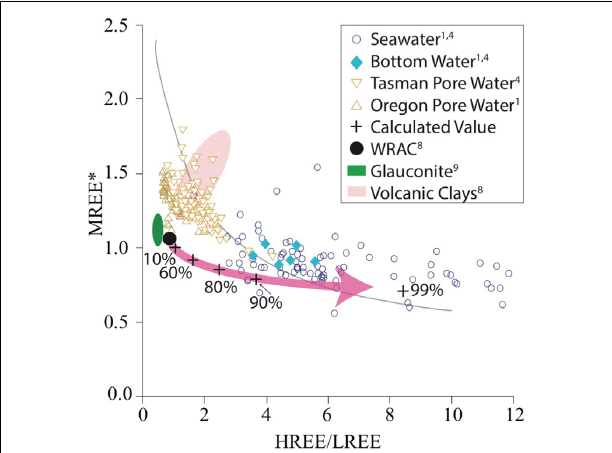
FIGURE 9 | HREE/LREE versus MREE ∗ of pore water and sedimentary phases including pore water (brown) and seawater (blue) from the six sites (Abbott et al., 2015a; Abbott, 2019), clay size fraction from volcanic rivers (red envelope, data from Bayon et al., 2015), and glauconites (green envelope, data from Huggett et al., 2017). World river average clay (WRAC, dark black dot, data from Bayon et al., 2015), and calculated resulting pore water patterns (+) from a glauconite sink as discussed in section “Authigenic Clay Formation May Modulate Pore Water REE